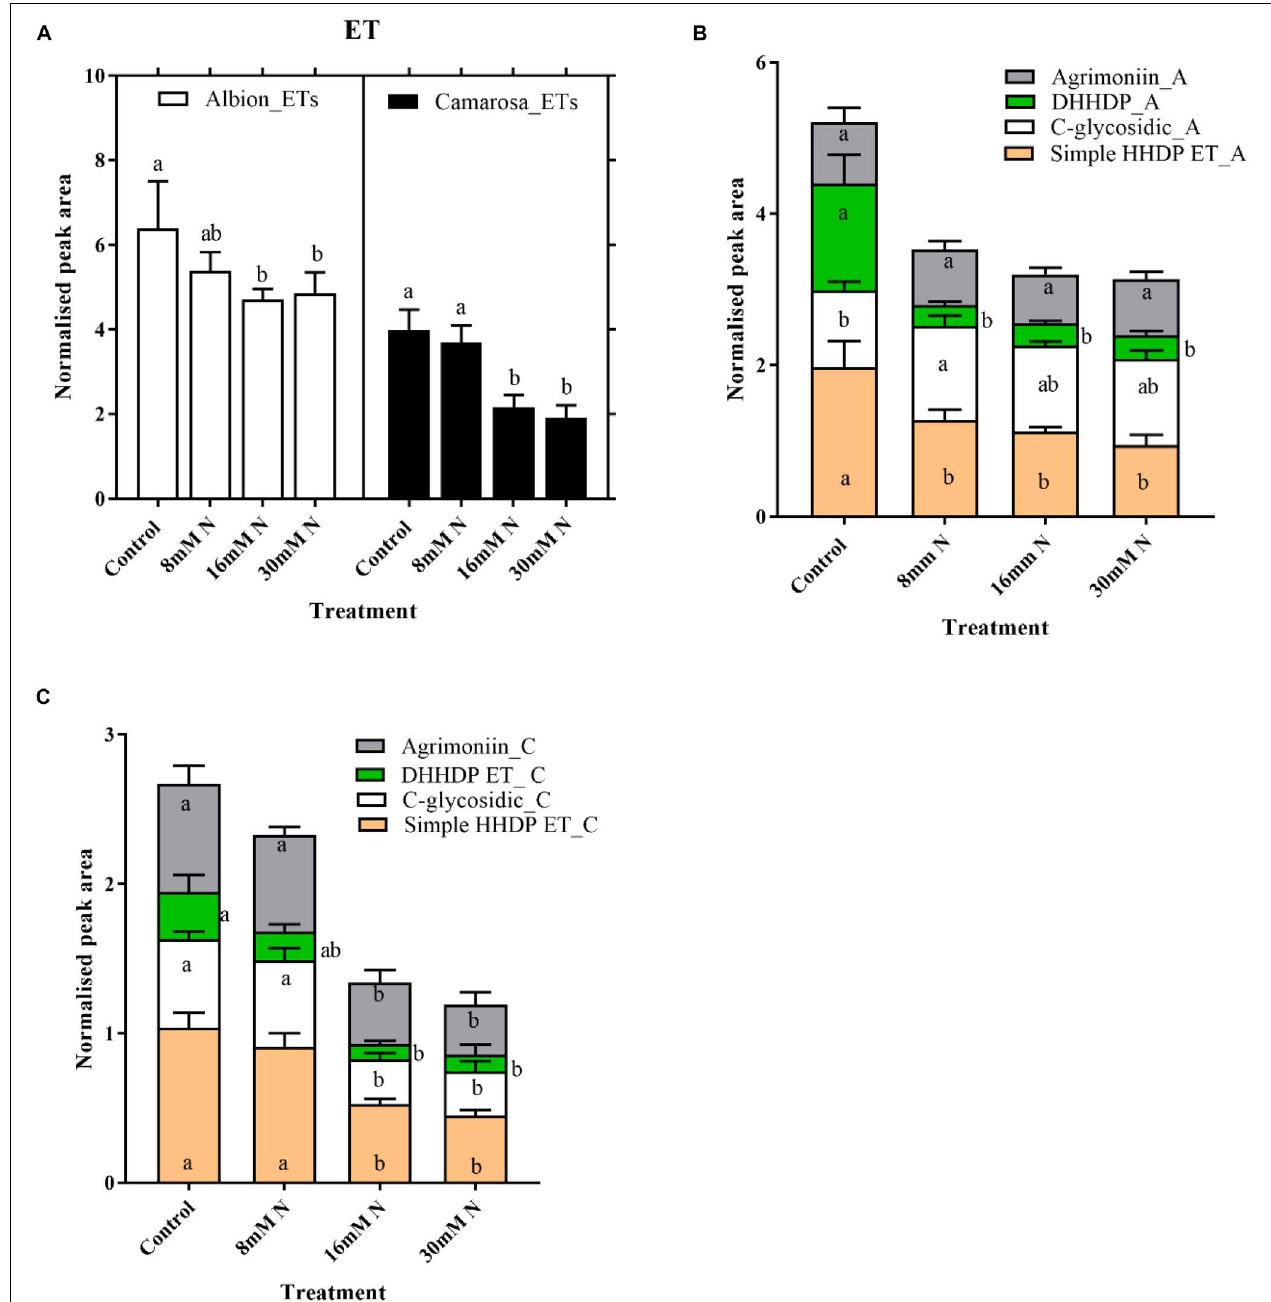
FIGURE 5 | Abundances of total ellagitannin (A) and different subgroups of ellagitannins in Fragaria ananassa cv. Albion (B) and cv. Camarosa (C) exposed to four N treatments. The data represent the mean ± SD ( n = 5) 13 C resveratrol (1 ng) normalized abundance and were tested by one-way ANOVA with Tukey’s honestly significant difference (HSD). Bars with the same letters are not significantly different at the 95% confidence